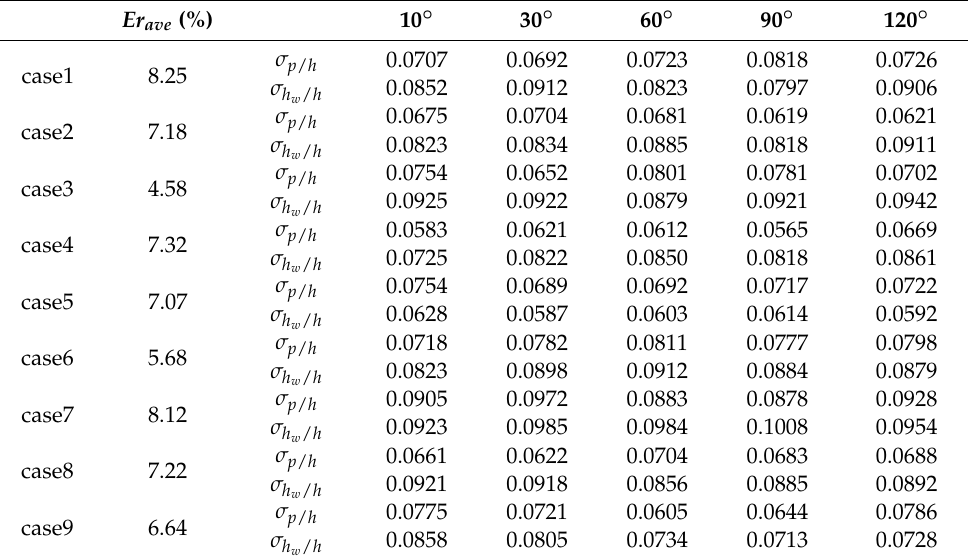
Table 2. Summary of the standard deviations of pressure and water surface in different locations at the same time period, where Er ave represents the average relative errors of the mass flow rate of inlet and outlet; σ p / h and σ h are the standard deviation of pressure and water w / h